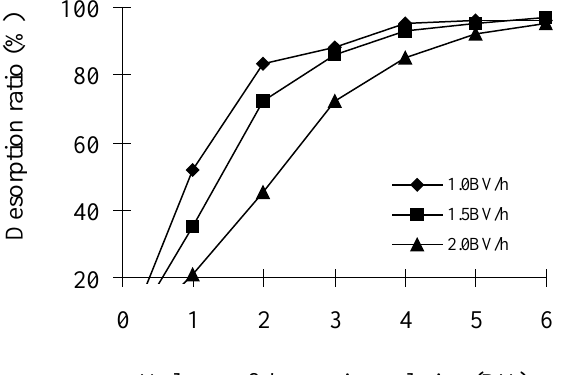
Figure 5. Effect of elution speed and volume of desorption solution on the neutral alumina column desorption.